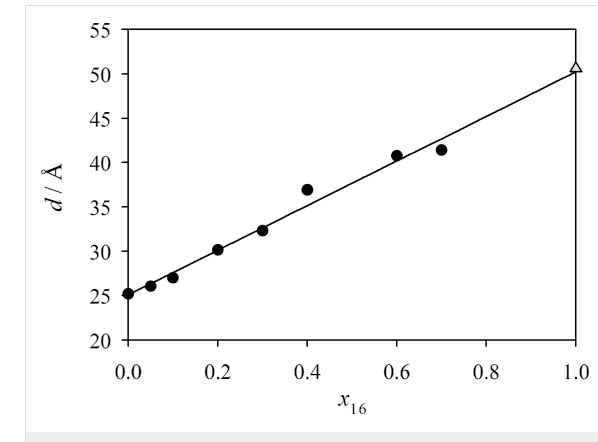
Figure 4: The layer spacing obtained by SAXS-measurements in the SmA phase at T = T c is plotted against the mole fraction x 16 (closed circles) as well as the molecular length for pure PhP16 calculated by molecular modelling (grey